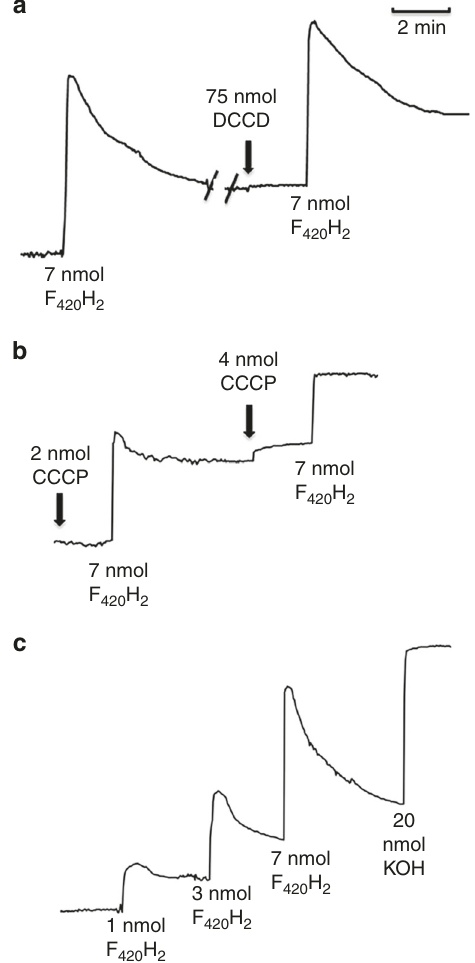
Fig. 4 Proton uptake in everted membrane vesicles dependent on coenzyme F 420 H 2 :Fe(III) oxidoreductase activity. The reaction mixtures (2.0 ml) contained 40 mM KSCN, 0.4 M sucrose, 10 mM dithiothreitol and Fe(III)-loaded vesicles (0.5 mg protein) from methanol-grown cells in 2 mM potassium phosphate buffer (pH 7.0) and the indicated fi nal concentration of reduced coenzyme F 420 (F 420 H 2 ). Additional reagents were added as indicated with fi nal concentrations shown. a Effect of dicyclohexylcarbodiimide (DCCD). b Effect of carbonyl cyanide m - chlorophenyl hydrazine (CCCP). c Effect of increasing concentrations of F 420 H 2 . The difference between the starting baseline and the fi nal baseline represents alkalinization of the medium dependent on